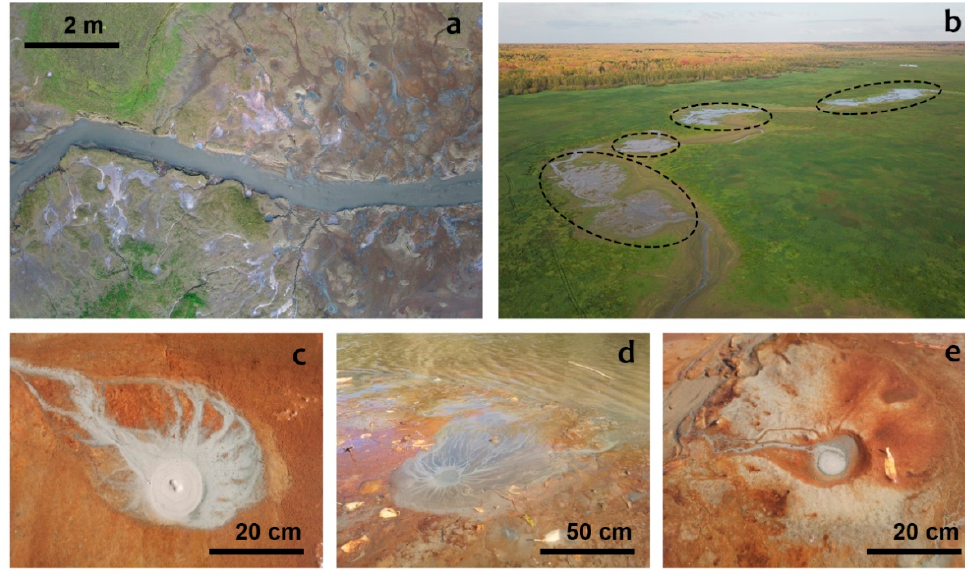
Figure 1. Seeps and seep areas within the study region: ( a ) active seep area along the small creek (white and grey areas correspond to colloid flows from active seeps); ( b ) several seeps areas along the same creek in the Ob’ floodplain (prominent waterlogged enlargements of the channel which are visible on Sentinel-2 and cover about 0.25 ha each); ( c – e ) individual seeps forming the seep area. To estimate seep areas at a regional scale, Sentinel-2 satellite imagery was used.